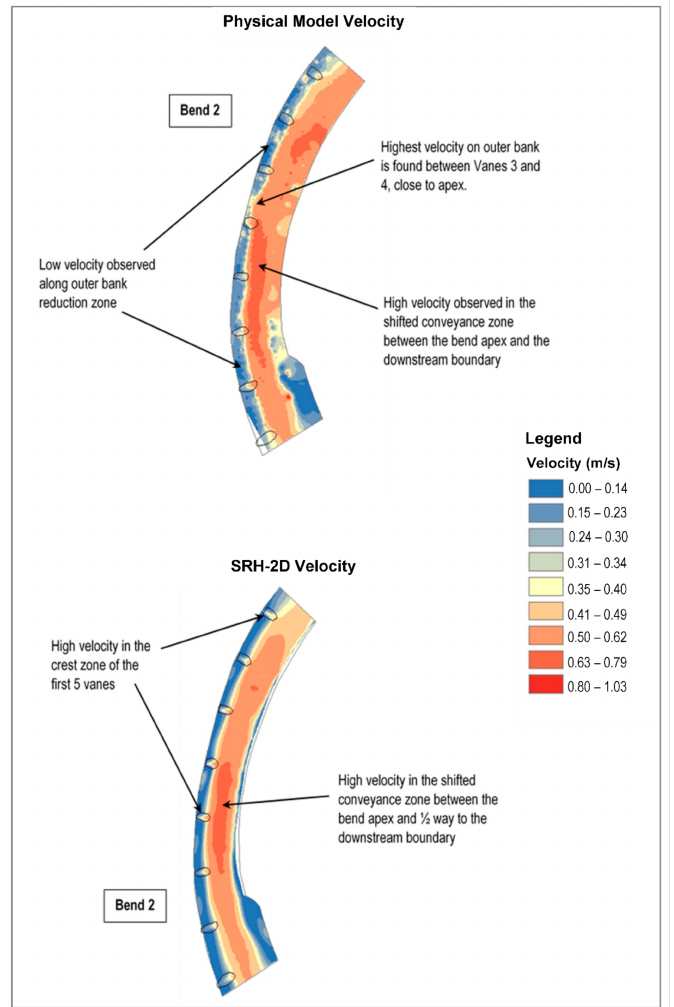
Figure 19. Rock vane configuration V01 comparison of physical model-measured and SRH-2D- predicted depth-averaged velocity